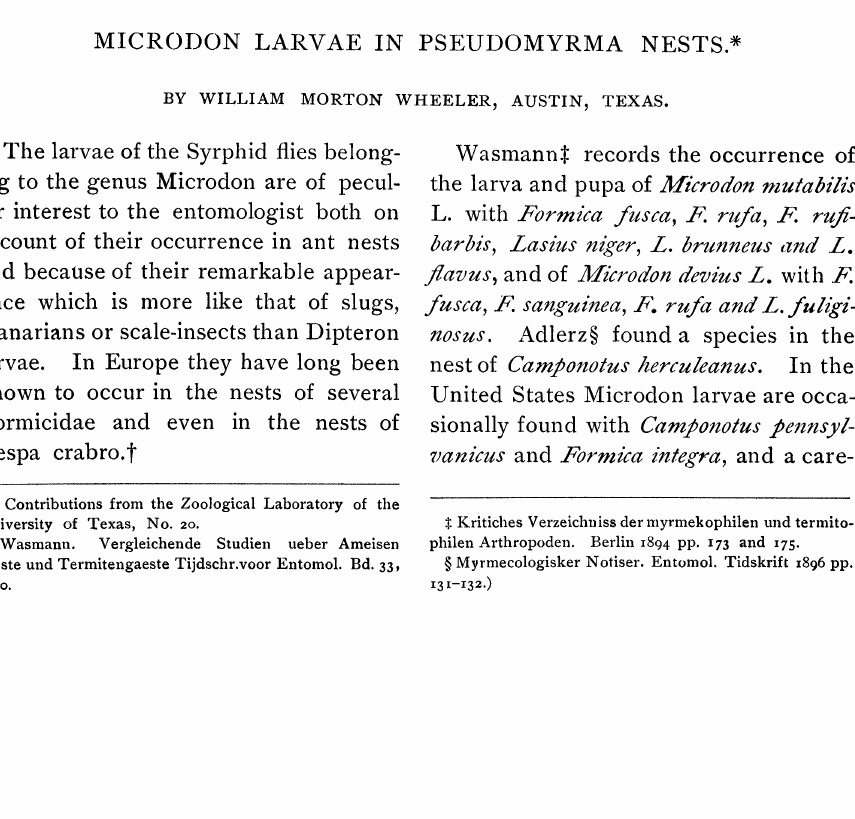
(figs. 9-II) five sixths as long as the dentes, lanceolate from the side, linear from above, serrate with entire apex. Head and body naked, excepting a few stiff anal setae; ap- Fig. I. Left aspect of left hind leg, X I8. Fig. 2. Diagram of a sagittal section show-